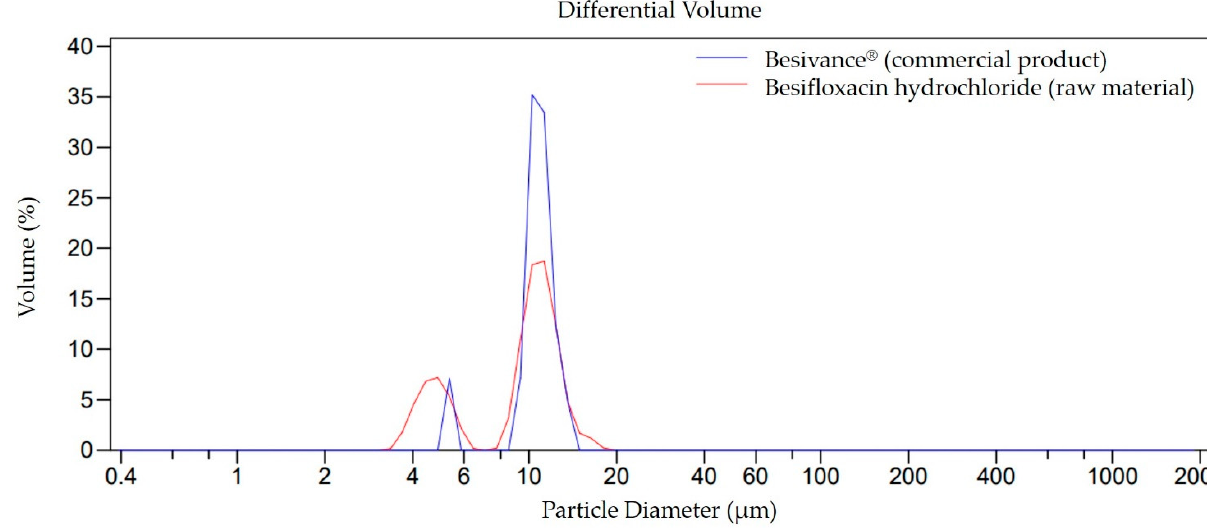
Figure 1. Particle size distribution for the commercial product Besivance ® and besifloxacin hydrochloride. The peaks represent the average of three readings .